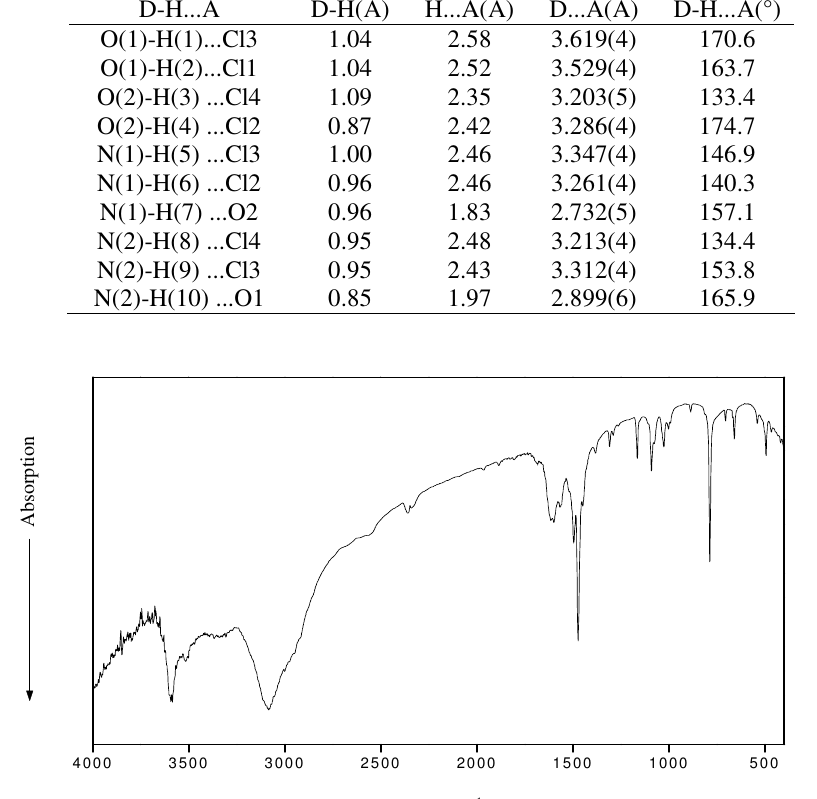
) -C H NH ] ZnCl 3 2 6 3 3 2